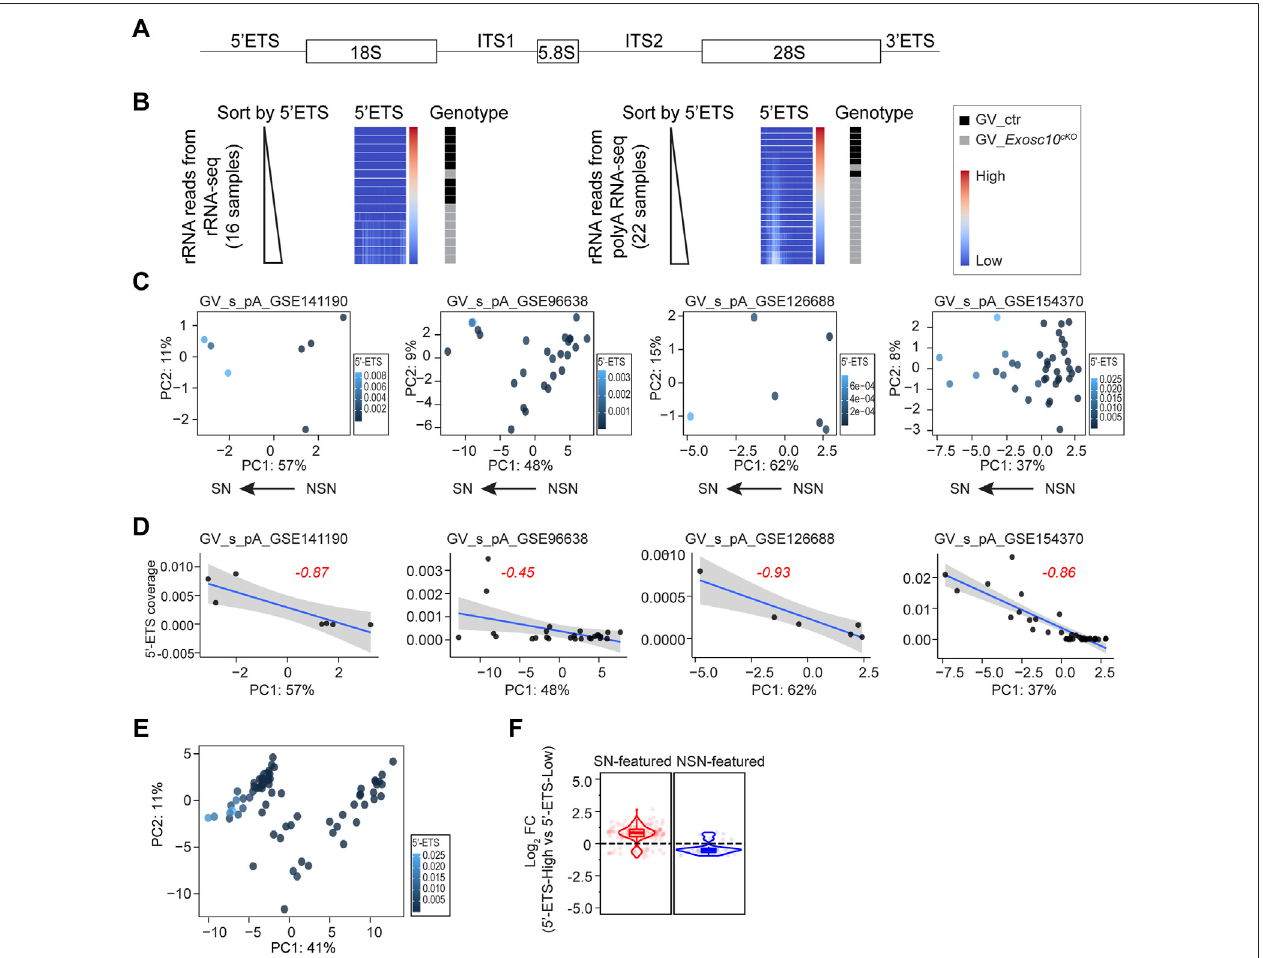
FIGURE3| rRNA5 ′ -ETSelevationcorrelateswithSNproperty. (A) SchematicofamammalianrRNAprimarytranscript,includingmaturerRNAfragments(18,5.8, and28 S),externaltranscribedspacers(5 ′ -ETS,3 ′ -ETS),andinternaltranscribedspacers(ITS1,ITS2). (B) HeatmapsofrRNAcoveragedocument5 ′ -ETSup-regulation in EXOSC10-depleted oocytes. Left: rRNA reads obtained from rRNA-seq; right: residual rRNA reads obtained from poly (A) RNA-seq. Each heatmap is sorted in ascending order of the 5 ′ -ETS coverage value. (C) PCA plots (the same as Figure 2A ) color-coded by the 5 ′ -ETS coverage values across all oocytes per dataset. (D) Regression analysis of PC1 and 5 ′ -ETS coverage in each dataset. Blue line is the predicted linear regression line with 95% con fi dence interval. Red number is the Pearsoncorrelationcoef fi cient. (E) PCAplot(thesamein Figure2B )color-codedbythe5 ′ -ETScoveragevaluesacrossalloocytes. (F) Log 2 foldchangeof5 ′ -ETS-High vs. 5 ′ -ETS-Low in the combined four datasets in E. Pre-de fi ned SN-featured and NSN-featured genes are shown in red and blue, respectively.